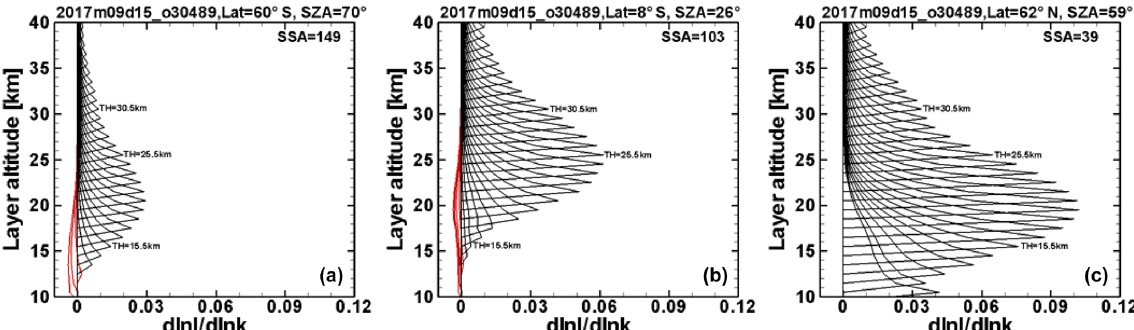
Figure 13. Example of aerosol weighting functions at a wavelength of 675nm for an altitude of 60 ◦ S (a) , 8 ◦ S (b) , and 62 ◦ N (c) . Each curve represents the sensitivity of the modeled LP radiance, I , at a given tangent height, TH, altitude, to a typical aerosol extinction, k , at each 1km altitude layer from 10 to 40km. The weighting functions are positive (black line) and peaked at different altitude ranges. At lower TH altitudes and for larger SA, the 675nm weighting functions become negative (red line) and lose sensitivity to aerosol extinction at lower TH